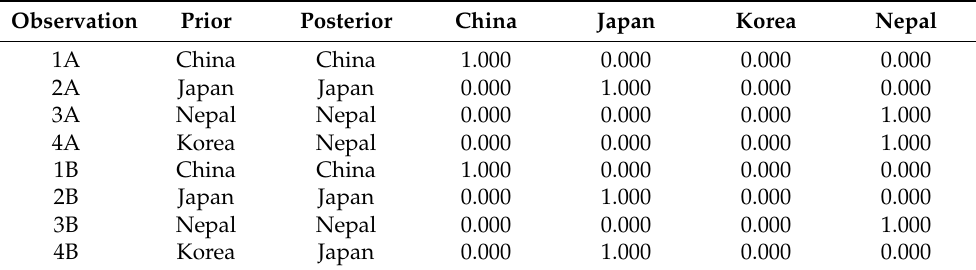
Table 8. Confusion matrix for the cross-validation results. From \ To China Japan Korea Nepal Total % Correct China